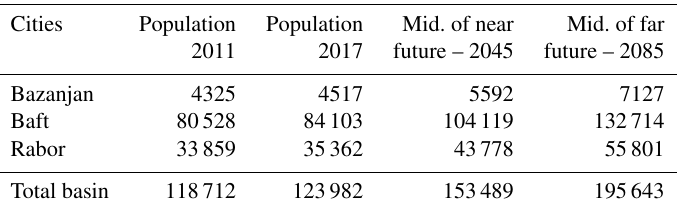
Table 2. Population of cities located in the Halilrood Basin according to the last census in 2017 and the future population projected based on the population growth rate suggested by PBO (2019).